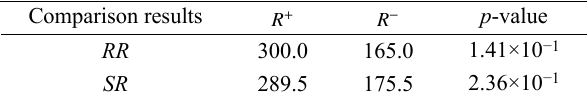
Table 9 Results obtained by the Wilcoxon test for ERLDE in terms of and compared with